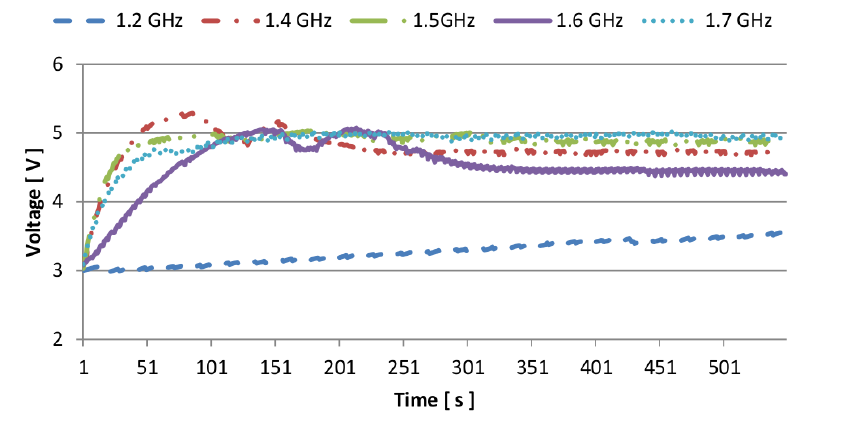
Measured supercapacitor voltage using adaptive sampling rate for different clock frequencies of the host